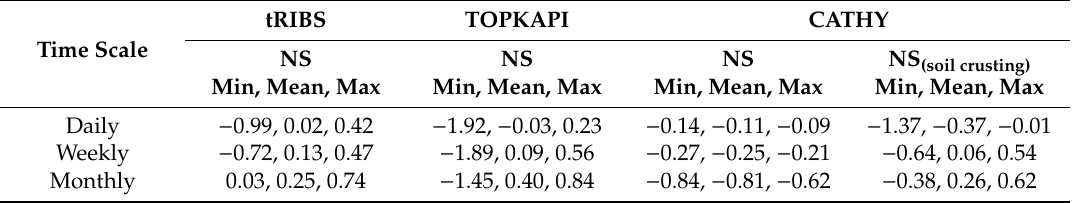
Figure 9. As Figure 5, but for the 1931–1932 period. For the CATHY model an hypothesis of soil crusting was assumed. ( a ) tRIBS; ( b ) TOPKAPI; ( c ) CATHY. Table 7. As Table 6, but for the 1931–1932 simulation period (validation period for tRIBS). For the CATHY model an hypothesis of soil crusting was